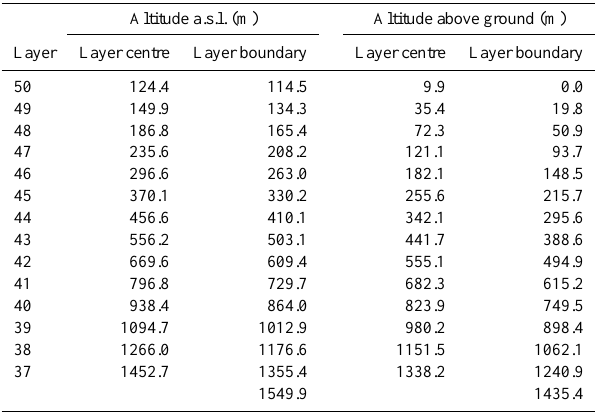
Table 1. Model layer altitudes and corresponding altitudes of layer centres above ground at the model grid position east of Theodor Shaft (52.2794 ◦ N, 7.7540 ◦ E). The first line of the table refers to the surface elevation.